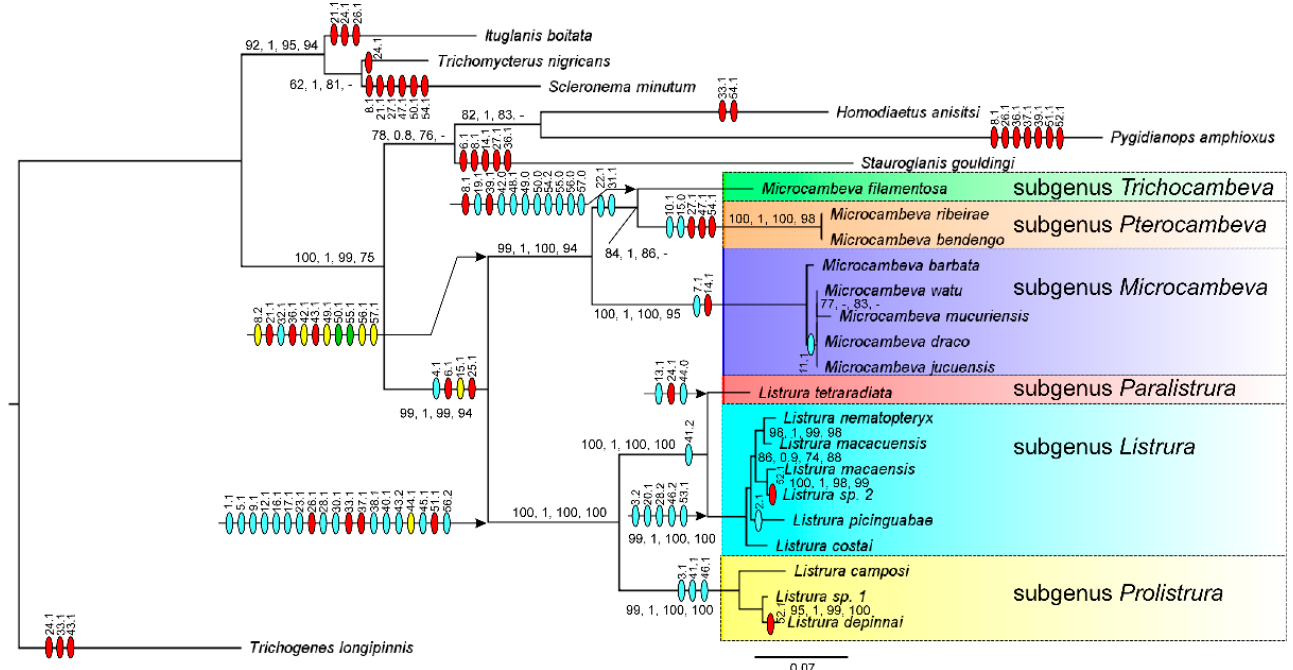
Figure 1. Phylogenetic tree generated by Maximum Likelihood analysis using IQ-TREE for 18 species of the Microcam- bevinae and seven outgroups, combining three genes (COI, CYTB, and RAG2, with a total of 2563 bp) and 57 osteological characters. Numbers near nodes in horizontal line are support values for phylogenetic analyses, in the following order: Shimodaira-Hasegawa-like procedure support (SH-aLRT) with values above 70%, the Bayesian-like transformation of SH-aLRT support (aBayes) with values above 0.9, and the ultrafast bootstrap support (UFBoot) with values above 70%, for the Maximum Likelihood (ML) analysis, and bootstrap values above 70% for the Maximum Parsimony (MP) analysis. Numbers near nodes vertically written are morphological characters followed by the respective character state after dot, numbered according to the Appendix C; symbol colours below numbers mean: light blue, unambiguous synapomorphies; red, apomorphic character states independently acquired in different analysed taxa; yellow, synapomorphies followed by reversals inside the clade; green, apomorphic character states independently acquired in different analysed taxa, followed by reversals inside the